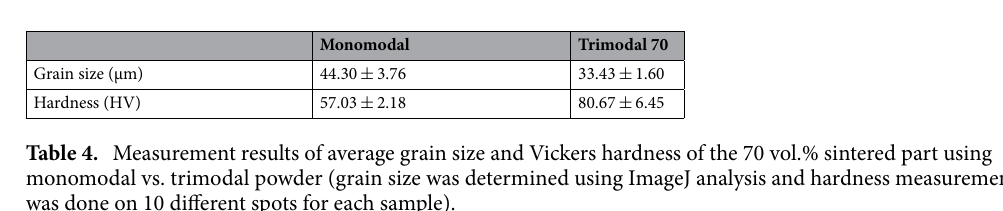
Figure 12. SEM images of sintered 70 vol.% parts using ( a ) monomodal and ( b ) trimodal sized Fe powder.